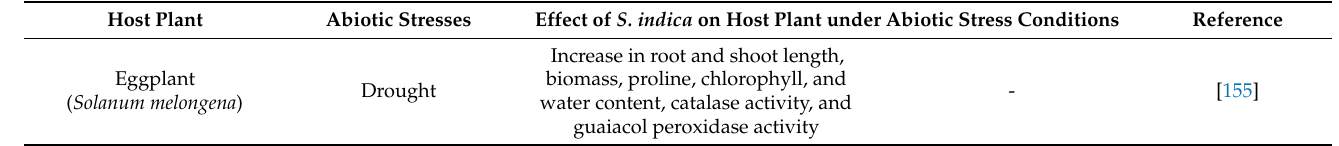
Table 3. Effects of S. indica on host plants under abiotic stress